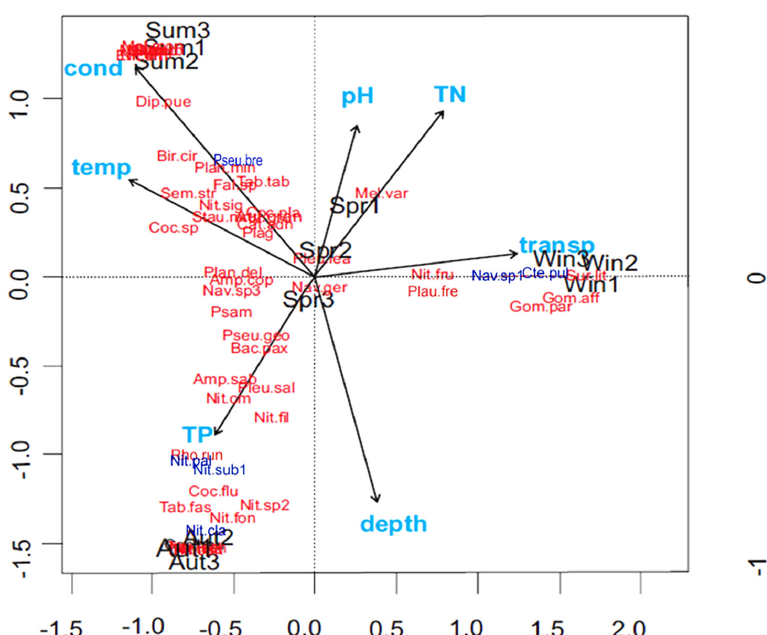
Figure 5. Canonical correspondence analysis (CCA) showing the distribution of the diatom community in relation to environmental factors (temperature (temp), electrical conductivity (cond), total phosphorus (TP), depth, transparency (transp), total nitrogen (TN) and pH) and seasons (autumn (Aut), winter (Win), spring (Spr) and summer